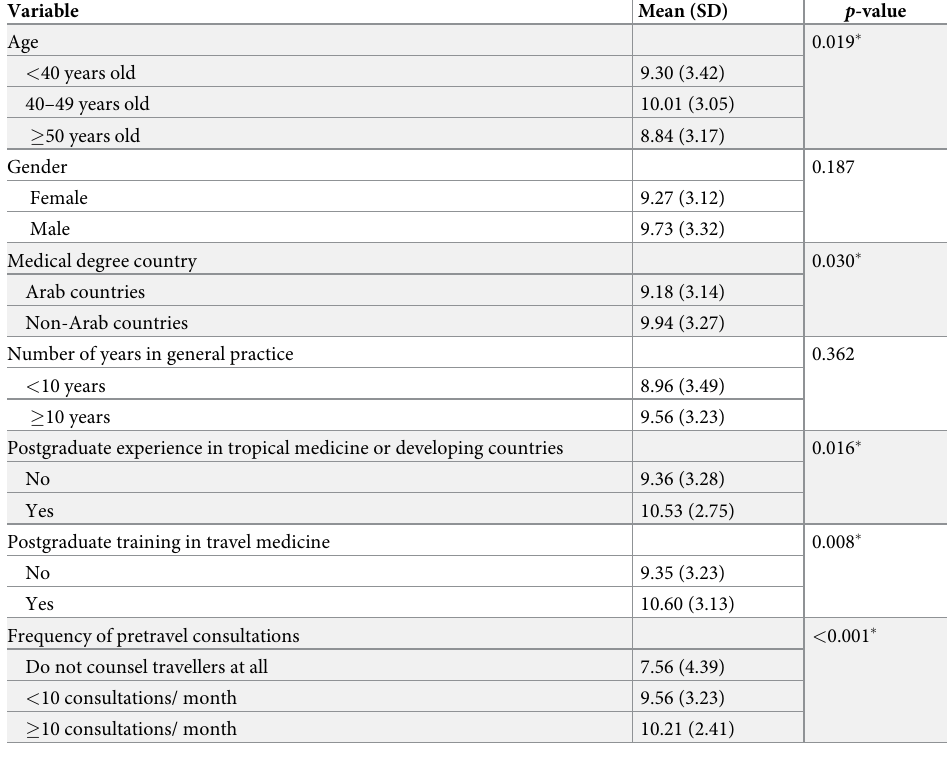
Table 4. Association between primary care physicians’ characteristics and their knowledge score in travel medi- cine (N =